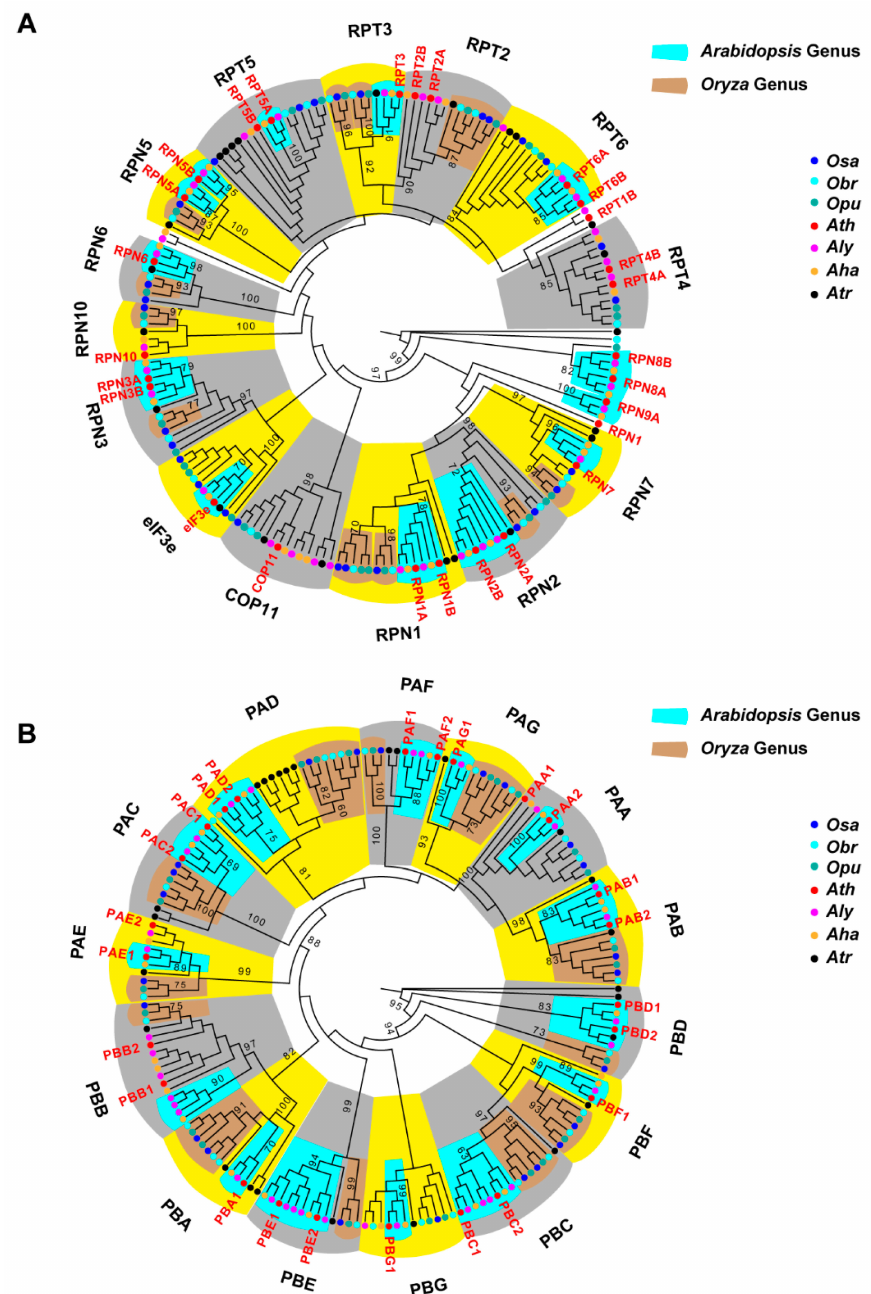
Figure 8. Phylogenetic analyses uncovered diversifying evolution of the 26S proteasome in Arabidopsis and Oryza genera. ( A ) Phylogenetic relationship of 9 RPN and 6 RPT subunits. ( B ) Phylogenetic relationship of the complete set of CP subunits. In each panel, the sequences of each member were annotated and subjected to a maximum likelihood phylogenetic analysis as described in Section 4. Detailed sequence IDs are described in Figures S3 and S4. The name of an Ath isoform is indicated in red. Subunit clades are alternately shaded with yellow and gray color. Statistical significance equal to or greater than 60% of 1,000 bootstrap re-samplings is indicated in a node that separates a significant clade. Significant clades from Arabidopsis or Oryza genus only are shaded with light blue or brown color,